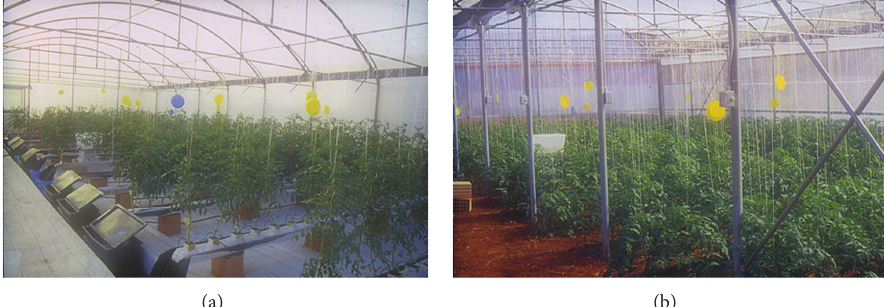
Figure 6: The greenhouses in the south of Italy where the Hydrogel effect on the cultivation of tomatoes was preliminarily tested.